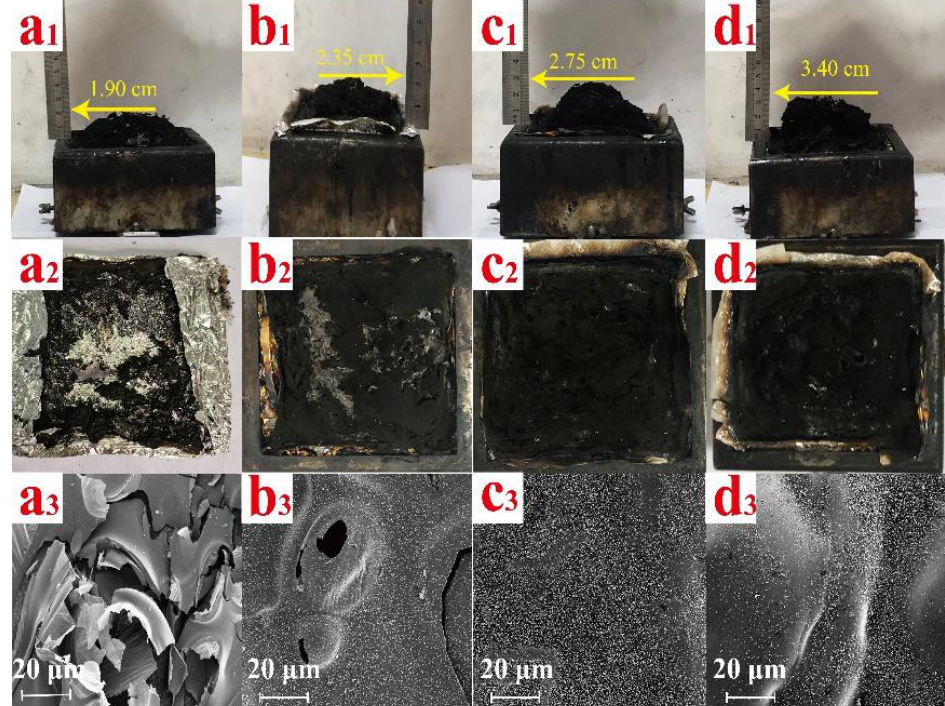
Figure 6. Digital photographs and SEM images of the residues char of EP ( a 1 – a 3 ), FREP-5 ( b 1 – b 3 ), FREP-7.5 ( c 1 – c 3 ) and FREP-10 ( d 1 – d 3 ).